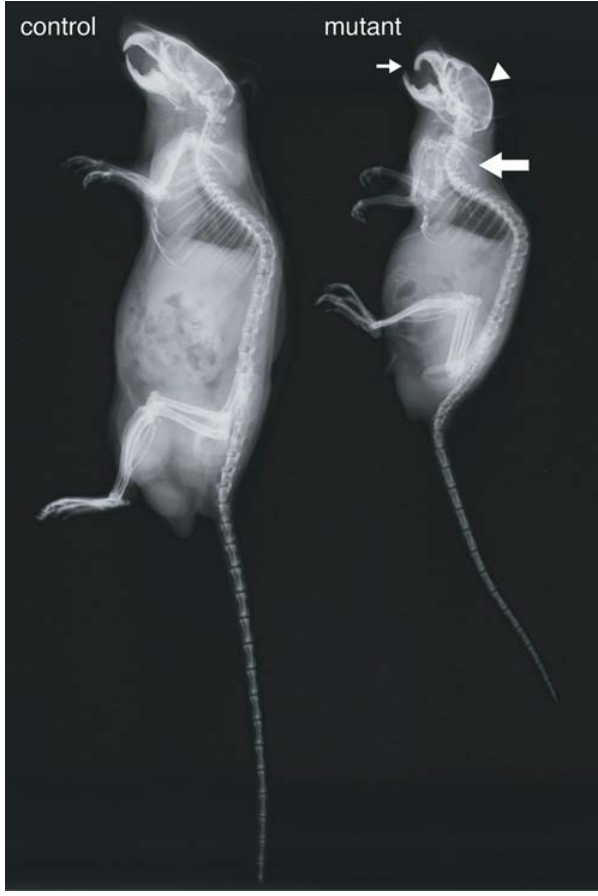
Figure 4. Radiographic analysis for 9-month-old R26 floxneoWnt4 ;Col2a1- Cremutants. The mutants had a smaller skeleton, abnormal skulls with a domed vault (arrowhead) and protruding incisors (small arrow). Kyphosis (large arrow) of the cervical-thoracic spine was also observed in the mutants. Control, R26 floxneoWnt4 heterozygote; mutant, R26 floxneoWnt4 ; Col2a1-Cre .